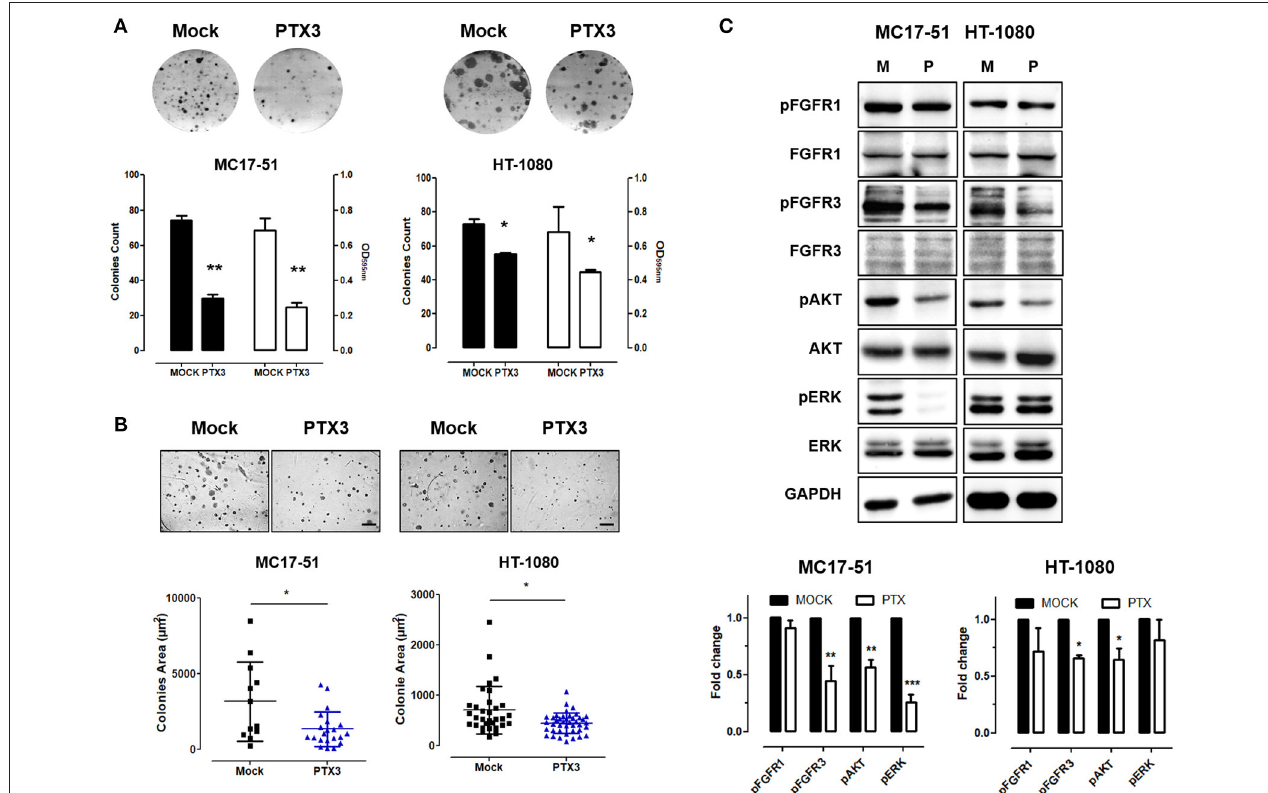
FIGURE 2 | PTX3 overexpression reduces the clonogenic capacity, anchorage independent growth and FGF/FGFR signaling in fibrosarcoma cells. (A) Mock- and PTX3-transfected MC17-51 and HT-1080 cells were seeded at low density. After 10 days, cell colonies were stained with crystal violet (upper representative images) and counted (black bars) or solubilized in 1% SDS and solution absorbance was measured at 595nm using a spectrophotometer (white bars). (B) Transfectants were grown in soft agar for about 3 weeks, cell colonies were photographed (upper representative images) and their area (in µ m 2 ) was measured. Scale bar: 0.25mm. (C) Western blot and corresponding densitometric analysis of FGF/FGFR signaling in mock- and PTX3- transduced MC17-51 and HT-1080 cells. In vitro data are the mean ± S.E.M of triplicate observations; Western blot analysis was performed twice; * P < 0.05; ** P < 0.01, *** P < 0.001 Student’s t